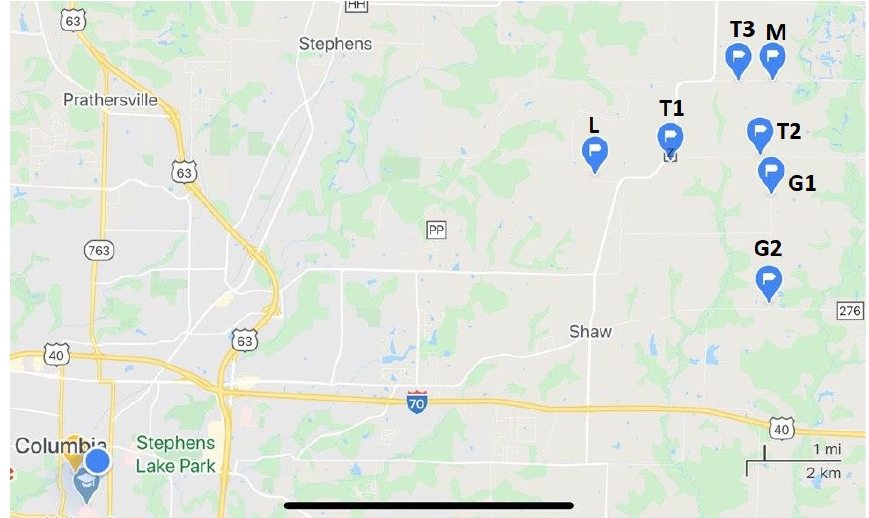
Figure 3. Sampling locations in the proximity of Columbia, Missouri.